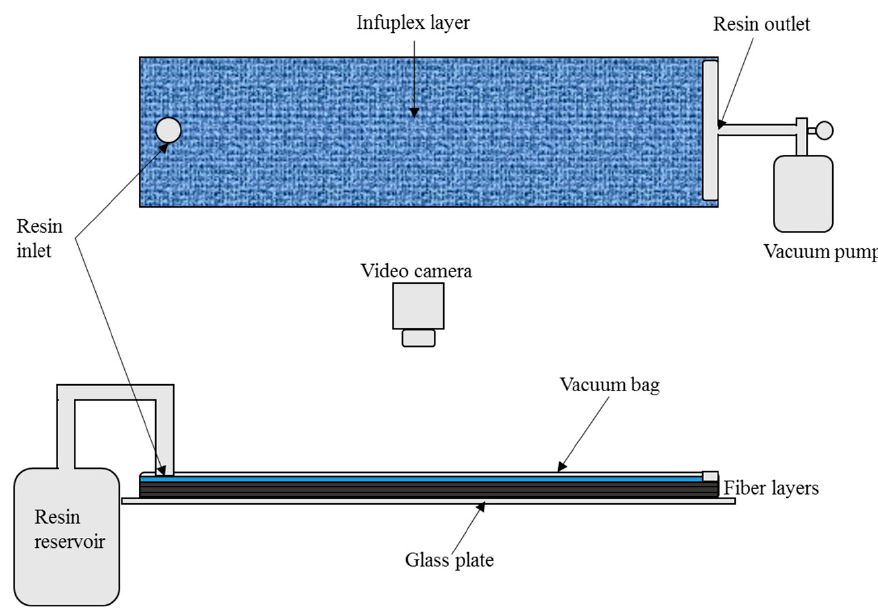
Figure 4. Experimental set up for manufacturing the laminates.